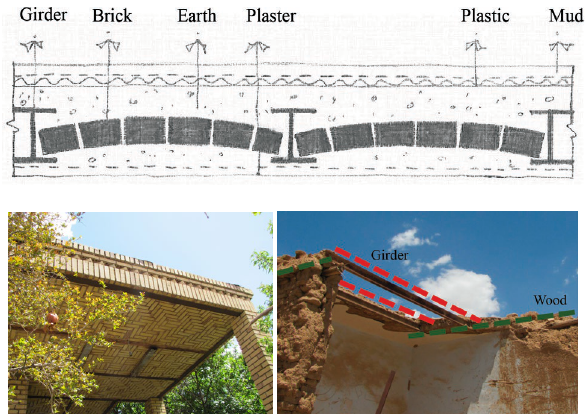
Figure 20. Girder and Zarbi vault, sometimes wood was used instead of the girder,